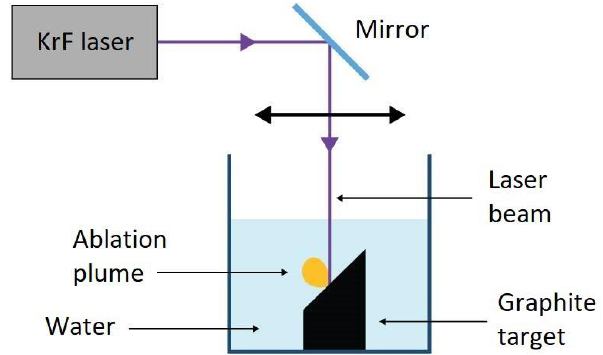
Figure 4. Experimental setup of pulsed laser ablation in liquid. Reproduced with permission from [40], Springer, 2018.